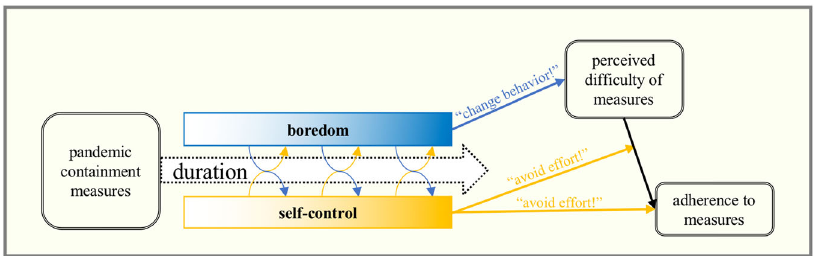
Fig. 1 Simpli fi ed adaptation of the theoretical model proposed by Wolff and Martarelli (2020) on the potential interplay between boredom and self- control during the current COVID-19 containment measures. The model proposes that boredom and self-control demands change over time ( duration arrow in the model), changes illustrated by the blue and yellow gradients highlighting increases in boredom and self-control demands during pandemic containment measures. Please note that changes must not be linear, the fi gure is schematic and meant to illustrate the dynamical interplay between boredom and self-control. According to the model, boredom signals whether one should explore behavioral alternatives ( “ change behavior ! ” arrow in the model) and self-control demands signal whether one should stop investing further effort ( “ avoid effort ! ” arrows in the model). We propose that adhering